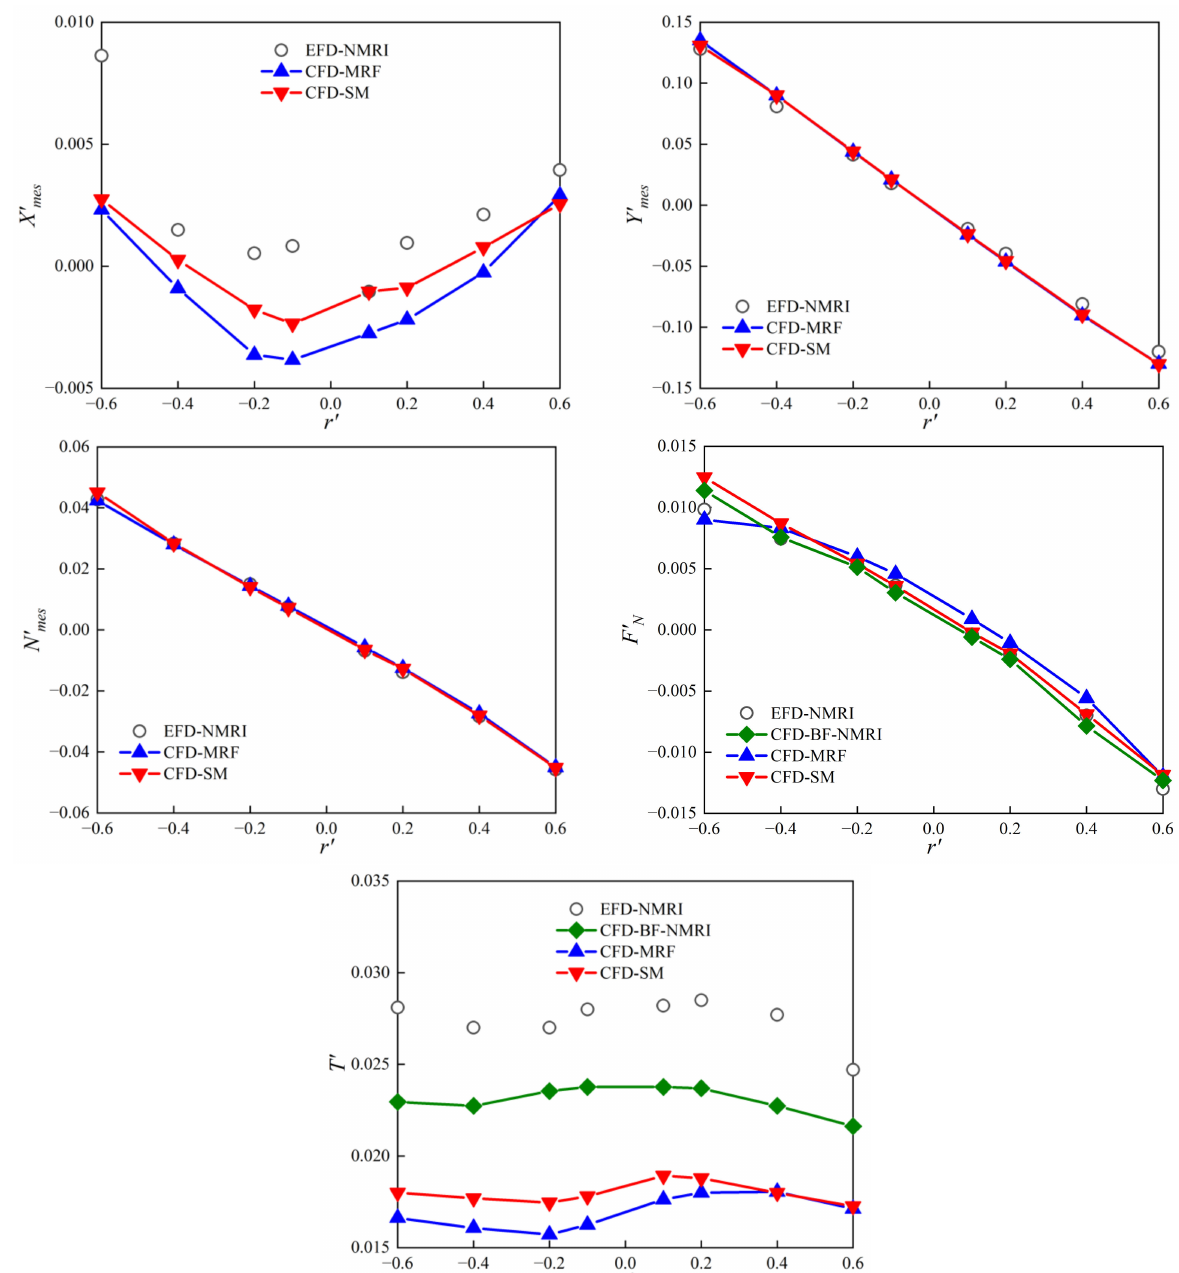
Figure 10. Hydrodynamic quantities in CMTs ( β = 0 ◦ ) obtained from experiments and